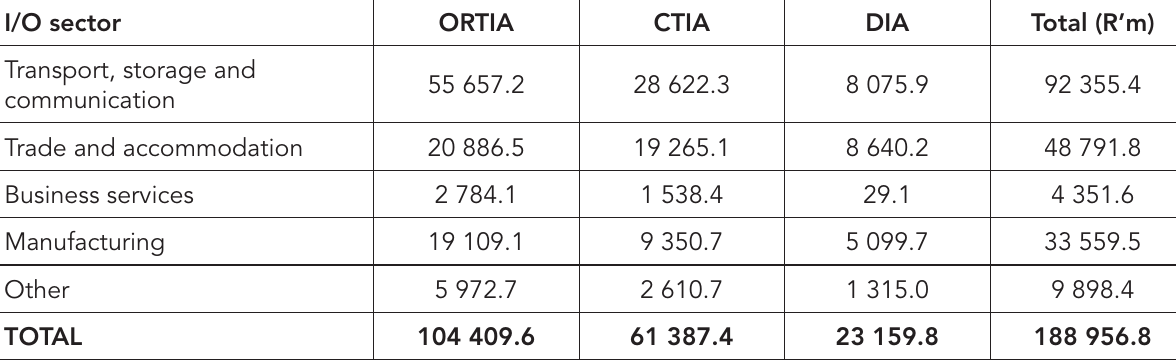
Table III: Total combined GDP impacts of